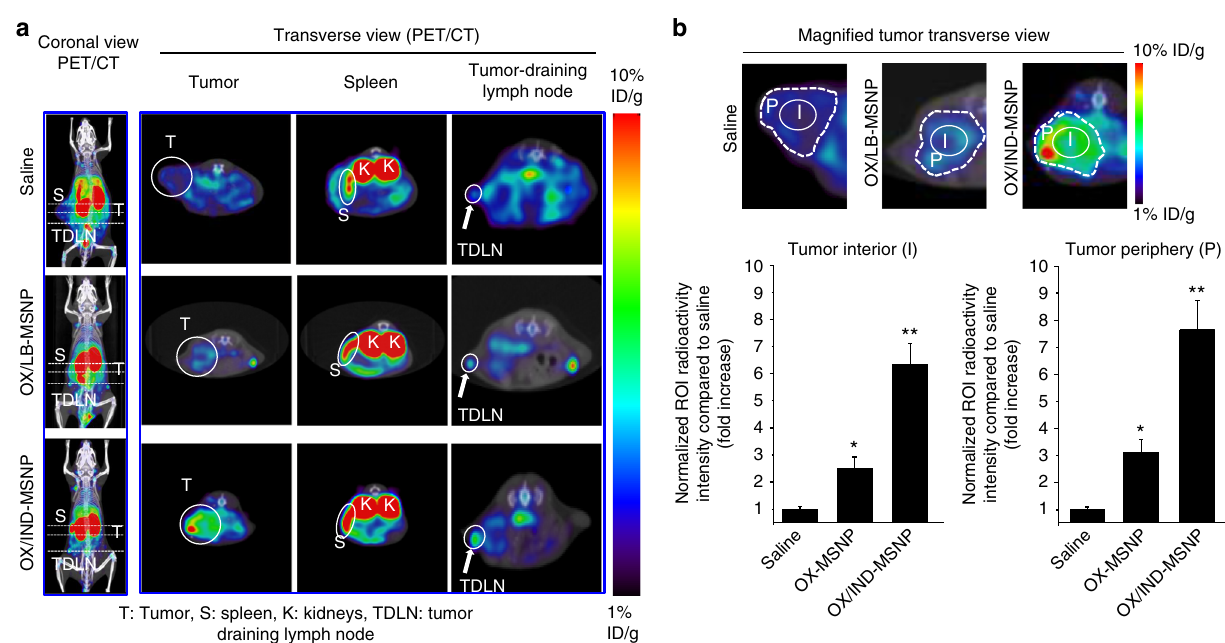
Fig. 7 Immuno-PET imaging to demonstrate the induction of the systemic immune response by OX/IND-MSNP administration to animals carrying orthotopic KPC tumors. a Animals with established orthotopic tumors ( n = 3/group) were IV injected with saline, OX/LB-MSNP (5 mg/kg OX), and OX/ IND-MSNP (5 mg/kg OX and 50 mg/kg IND on days 10, 14, 18, and 22 post KPC cell implantation into the pancreas. At day 26, 100 µ L doses containing 1.07 – 2.33 MBq (29 – 63 µ Ci, 2.3 – 5.3 µ Ci/ µ g) 89 Zr radiolabeled cDb in saline was IV injected to the same animals. 20 h later, microPET and CT scans were acquired by a G8 PET/CT scanner (So fi e Biosciences). Coronal (left panel) and transverse views (right panel) were acquired and analyzed by AMIDE software. OX/IND-MSNP-treated mice showed signi fi cantly increased radioactivity in the tumor, spleen, and TDLN, corresponding to the induction and in fi ltration of CD8 + T cells. b To evaluate the CD8 + signal at the tumor site, the operator-de fi ned ROIs were used to demonstrate a 6.2- and 7.5-fold increase in the signal intensity in the tumor interior and periphery, respectively, during OX/IND-MSNP compared to saline treatment. The results are expressed as mean ± SEM. * p < 0.05; ** p < 0.01,